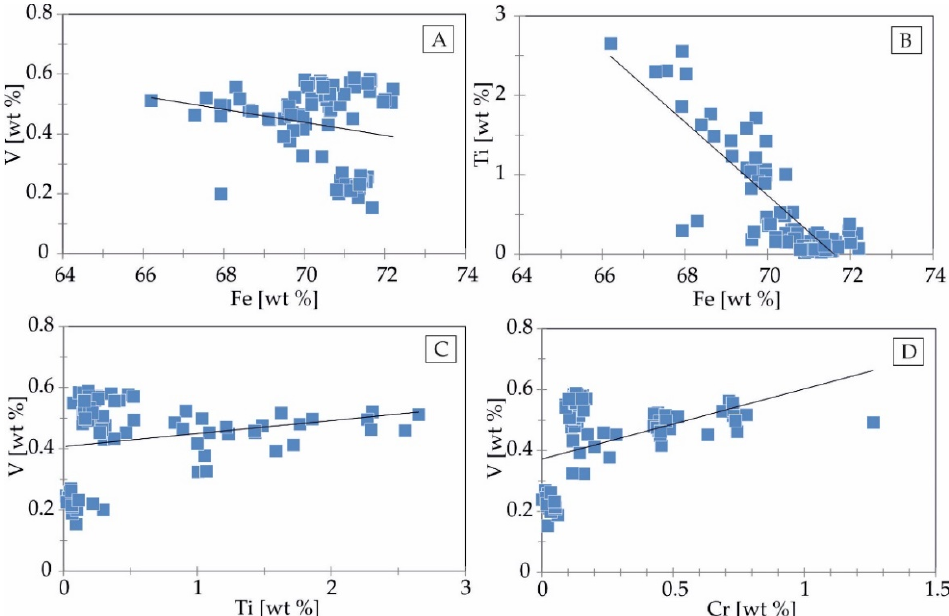
Figure 14. Bivariate diagrams of iron vs. vanadium ( A ), iron vs. titanium ( B ), vanadium vs. titanium ( C ), and chromium ( D ) in magnetite from the Udryn and Krzemianka Fe-Ti-V deposits. Trend lines represent correlations between elements. All plots represent the same set of samples; 0 values and samples with values below the level of precision of a single measurement are not presented on the axis.